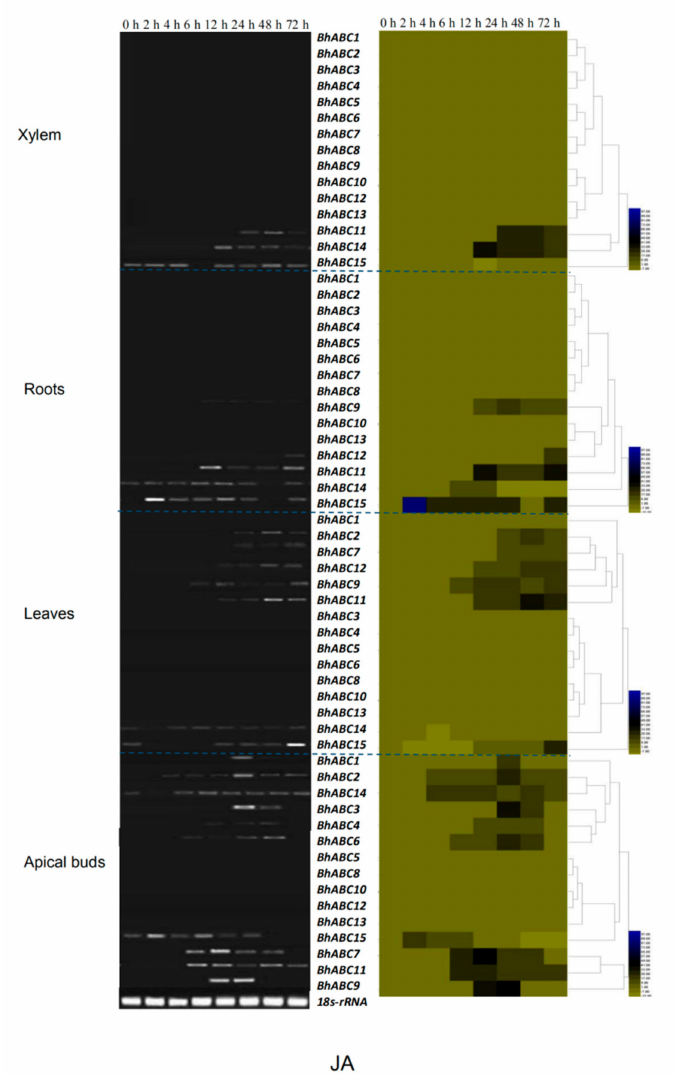
Figure 7. Expression patterns of BhABC genes in xylem, roots, leaves, and apical buds after JA treatment. Heat map showing responses of BhABC genes to JA (right); semi-quantitative RT-PCR analysis with 18s RNA internal reference